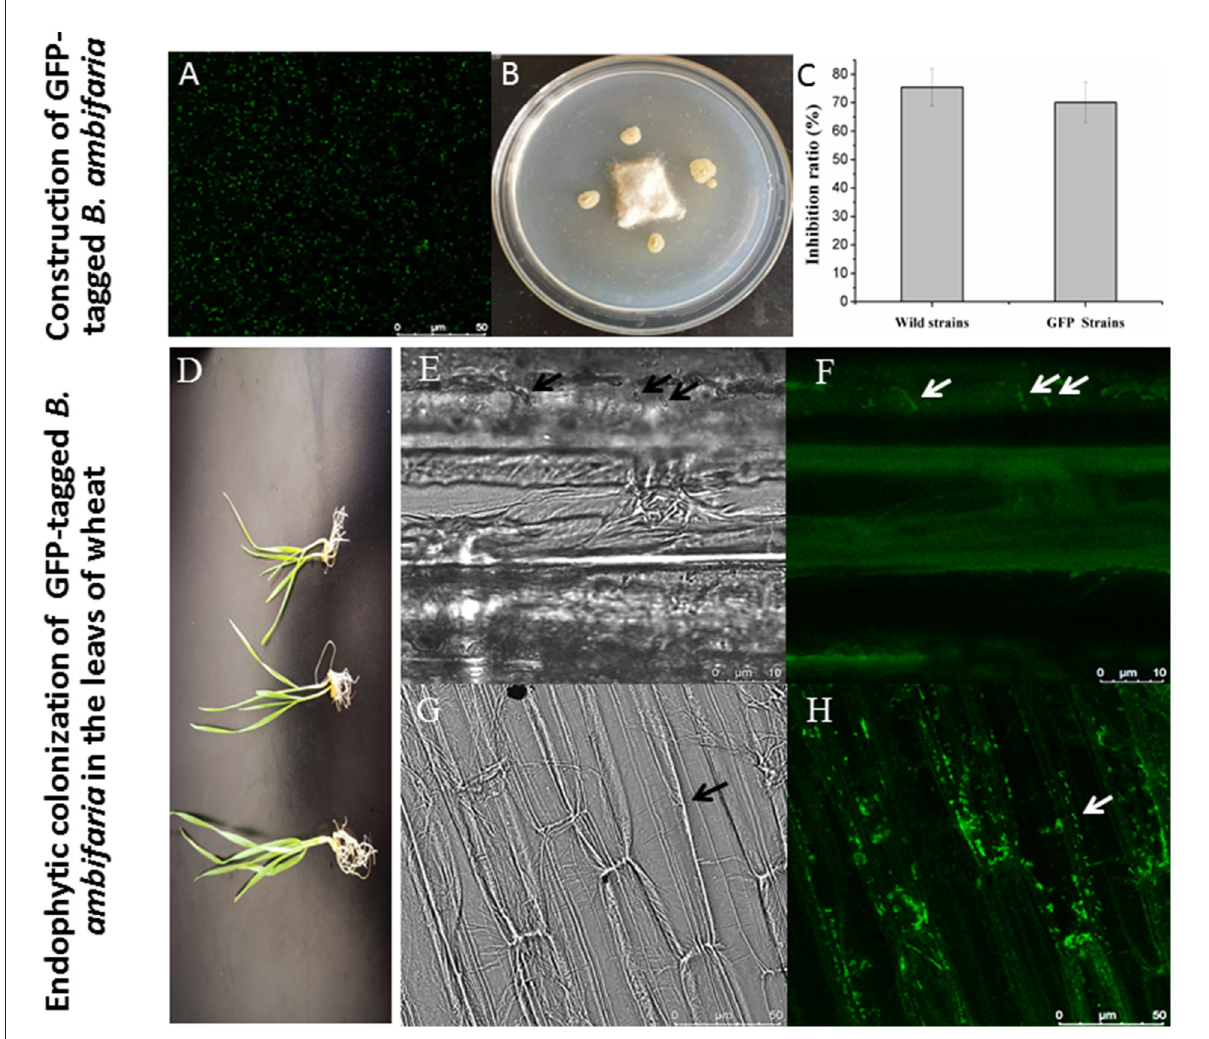
FIGURE3 Colonization of GFP-tagged B. ambifaria in the seedlings of wheat. The observation of GFP-tagged B. ambifaria by CLSM (A) , antagonistic activities against R. cerealis (B,C) , the wheat seedlings inoculated GFP-tagged B. ambifaria at different growing stages (D) , colonization of GFP-tagged B. ambifaria XN08 at 2 days after inoculation (photographs under dark (E) and bright (F) fields) and 7 days after inoculation (photographs under dark (G) and bright (H)